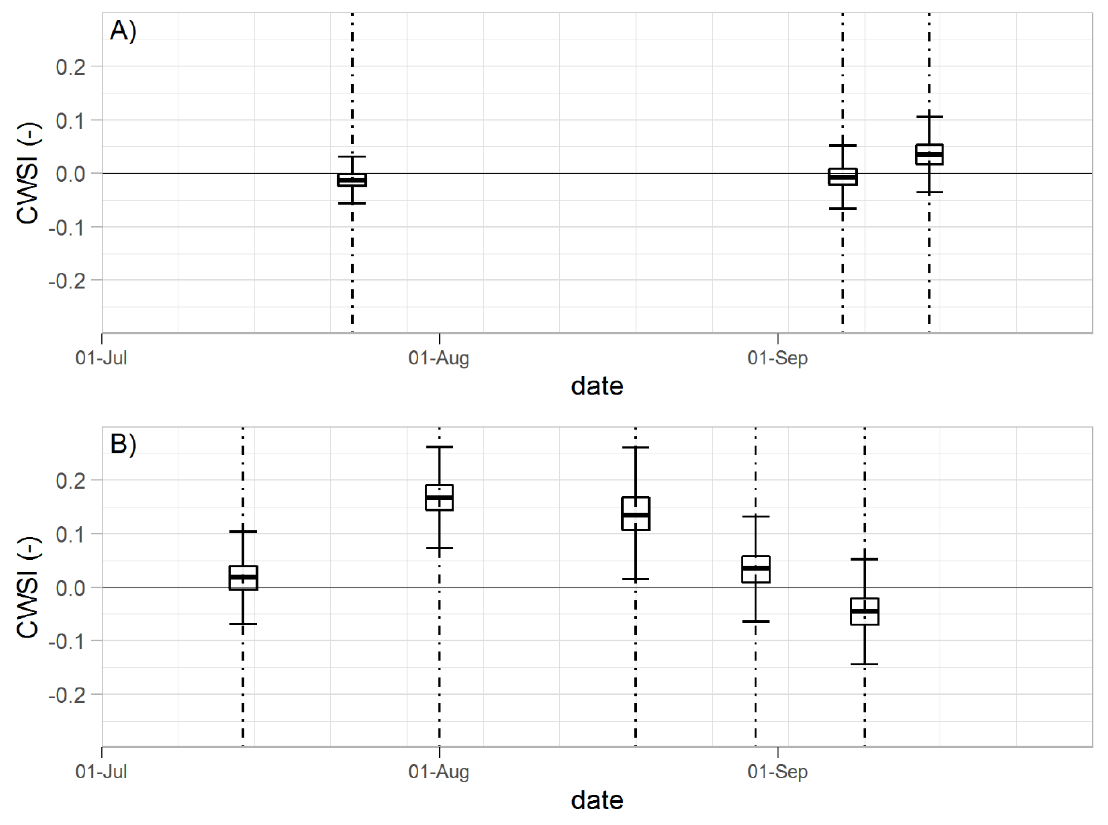
Figure 5. The CWSI values distribution for ( A ) The Biebrza National Park and ( B ) the Janów Forest Landscape Park. The boxplot shows the median, the lower and upper hinges correspond to the first and third quartiles, respectively, the upper and lower whiskers are the 1.5 · interquartile range, respectively, and the dash-dotted vertical lines indicate UAS flight campaigns (Table 1).